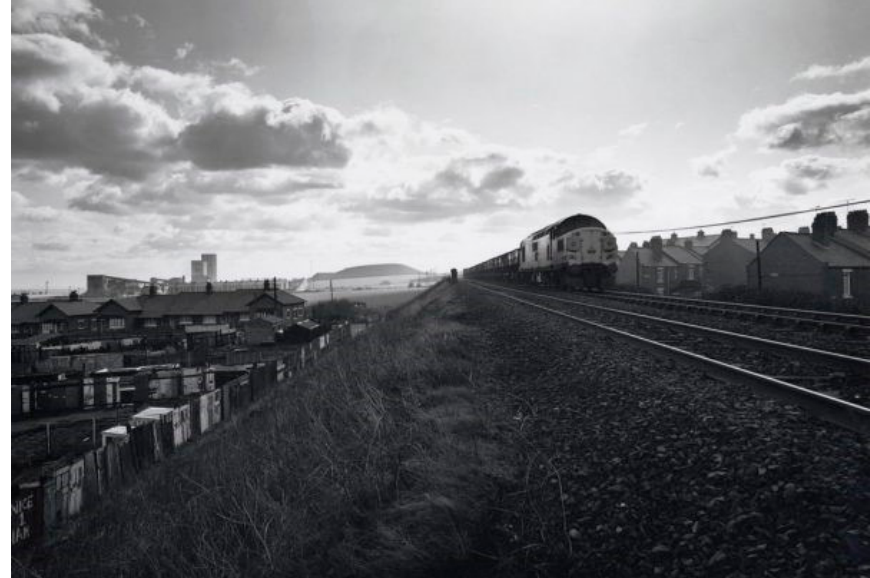
Figure 2. John Davies, Coal Train, Dawdon Colliery, Seaham , 1983. © John Davies 1983. Reproduced with kind permission of John Davies and Amber/Side. 5